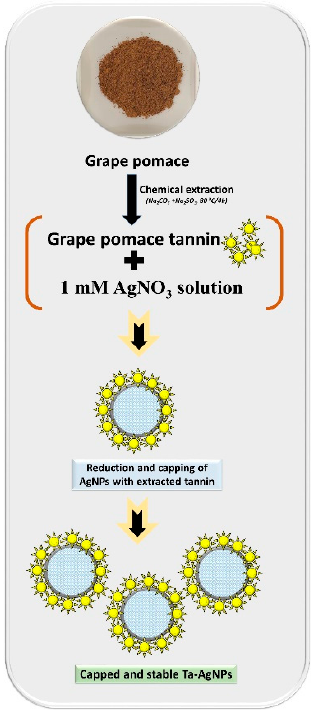
Figure 3. Schematic representation of the grape pomace tannin mediated synthesis of Ta-AgNPs.